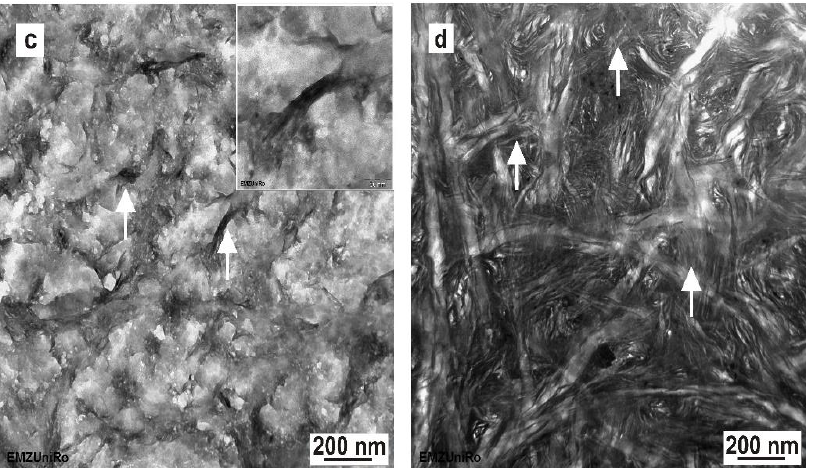
Figure 4. Comparison of ultramicrotome and in situ FIB lift-out-prepared human mineralized dentine. ( a ) Ultramicrotome-prepared dentine section showing the peritubular (PTD) and intertubular dentine (ID) interface; (DT) dentinal tubule ( b ) In situ FIB lift-out-prepared dentine section showing the highly mineralized peritubular dentine (PTD) and the less mineralized intertubular dentine (ID); (DT) dentinal tubule. ( c ) Ultramicrotome-prepared intertubular dentine. The inset in c is a magnified TEM image of a hydroxyapatite crystal bundle. ( d ) In situ FIB lift-out-prepared intertubular dentine